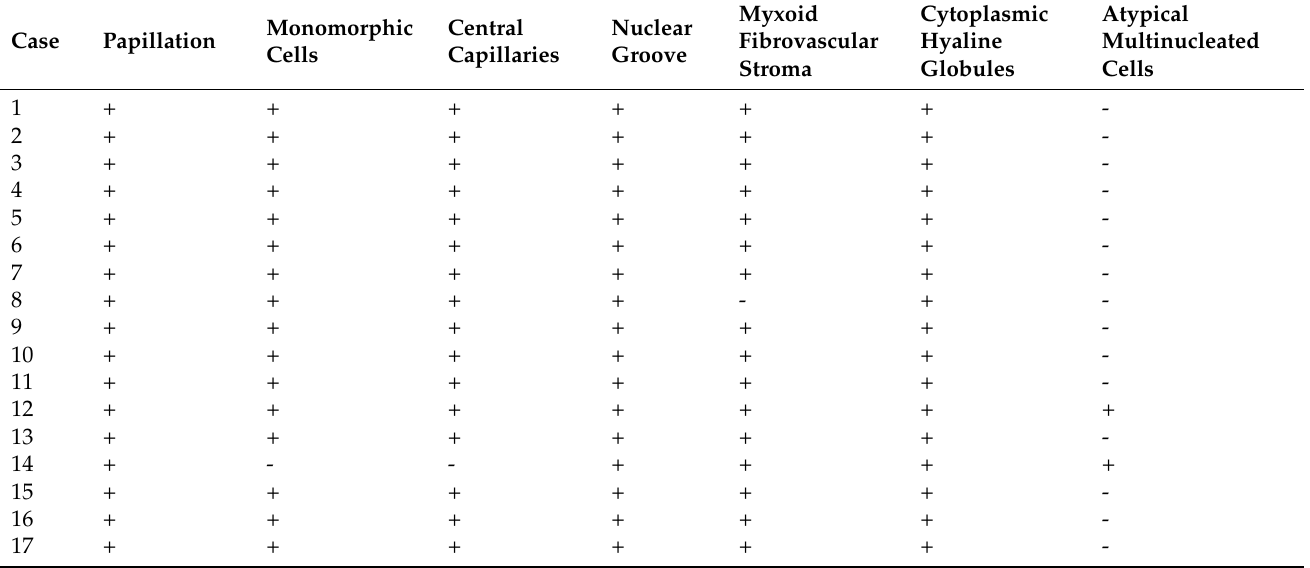
Table 2. Cytomorphology of 17 SPNs of the pancreas on FNA smears/touch prints and cell